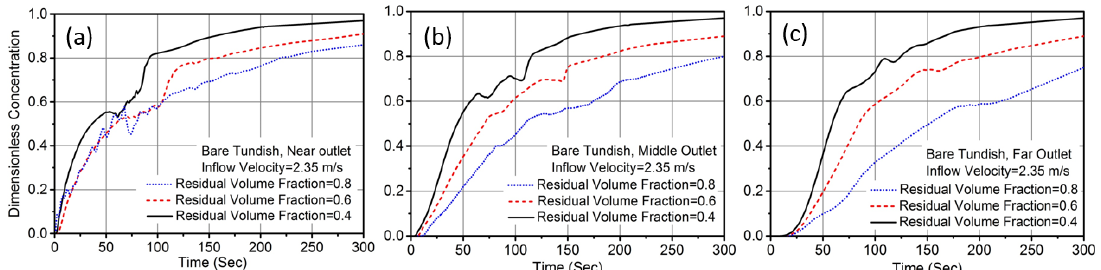
Figure 6. F-curves by varying the residual volume of reduced scale bare tundish: ( a ) Near outlet, ( b ) middle outlet, and ( c ) far outlet.